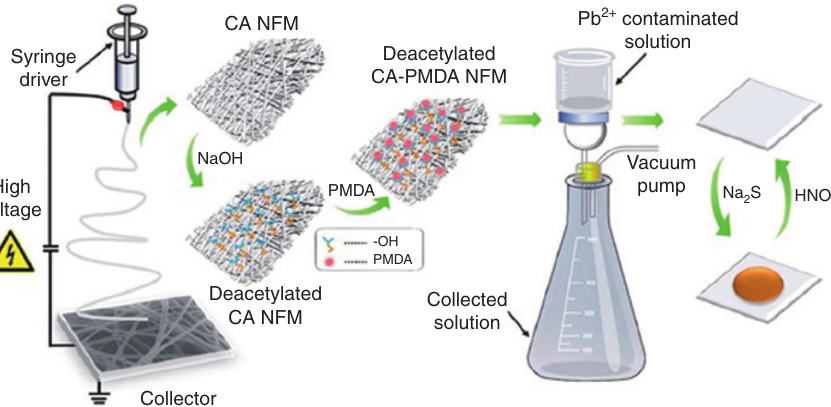
Figure 24: Schematic illustration of the fabrication procedure of DCA-PMDA NFM and simultaneous colorimetric detection and enrichment of target Pb 2 + by DCA-PMDA NFM. For details, see Ref. [102]; reprinted with permission from Royal Society of